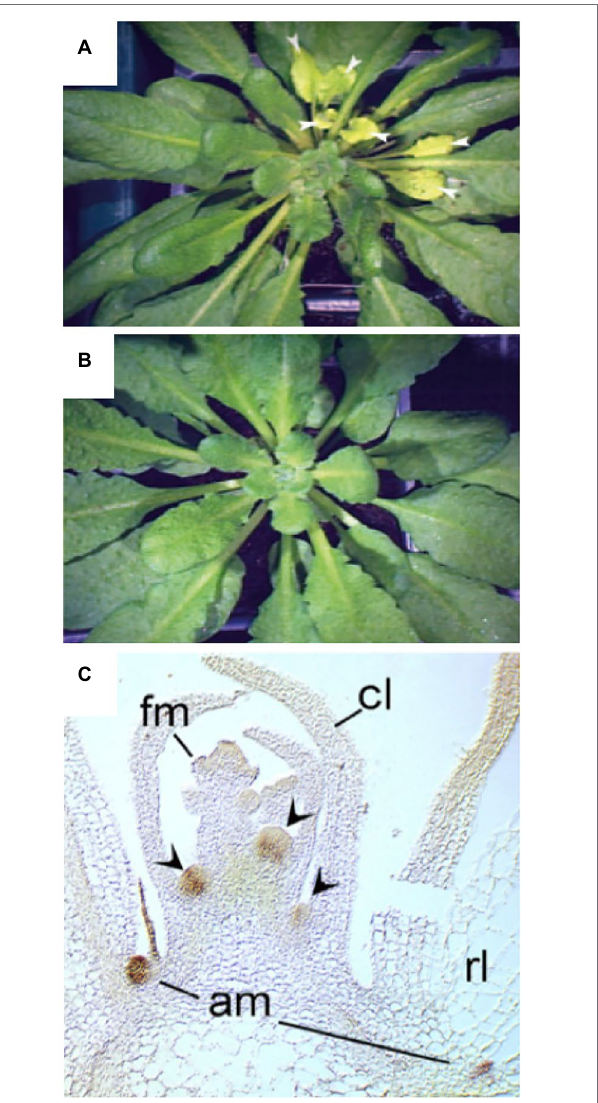
FIGURE 5 | Local action of SL through MAX2 and BRC1 in leaf axillary meristems. (A,B) Clonal analysis with max2 mutant sectors reveals local function of MAX2 in axillary buds. A sector marked by chlorophyll deficiency (yellowish leaves) comprised a single axillary bud that grew out to produce numerous leaves (arrowheads), that are identified as a max2 mutant sector by the cosegregating genetic defect in chlorophyll biosynthesis (A) . A wild-type control plant of the same age does not show bud outgrowth, nor yellowish leaves (B) . (C) Expression analysis of BRC1 by in situ hybridization reveals expression in axillary meristems (am), but not in floral meristems (fm) at the shoot apex, cl, cauline leaf; rl, rosette leaf. Modified with permission from Stirnberg et al., 2007 (A,B) , and Aguilar-Martinez et al., 2007 (C)